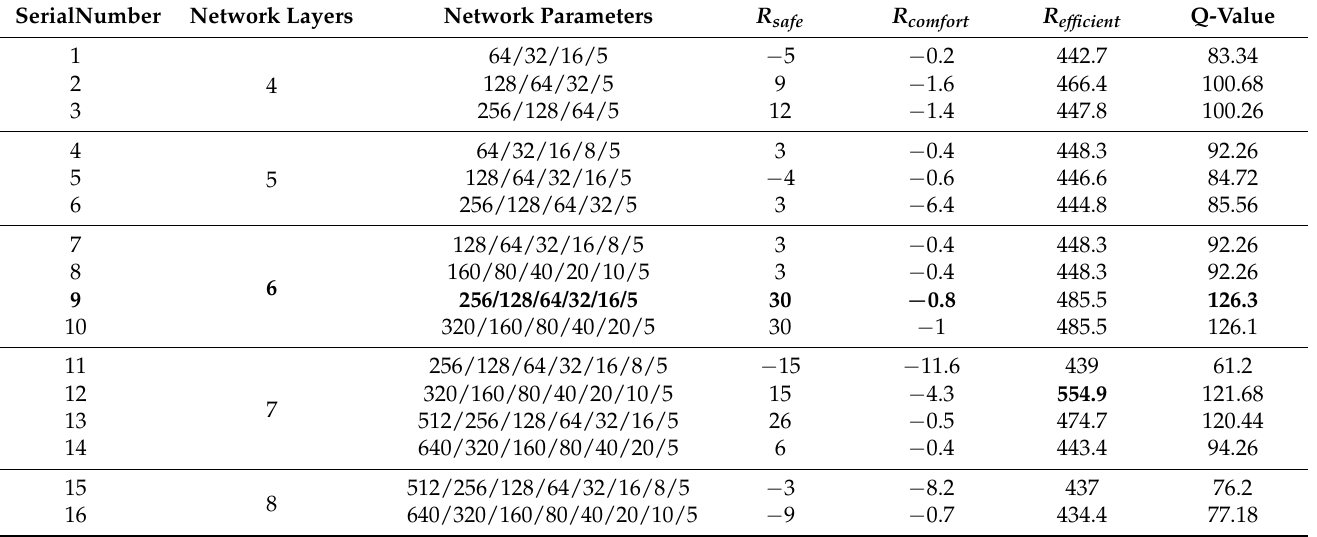
Table 2. Settings of CR-DRQN’s parameters and corresponding training